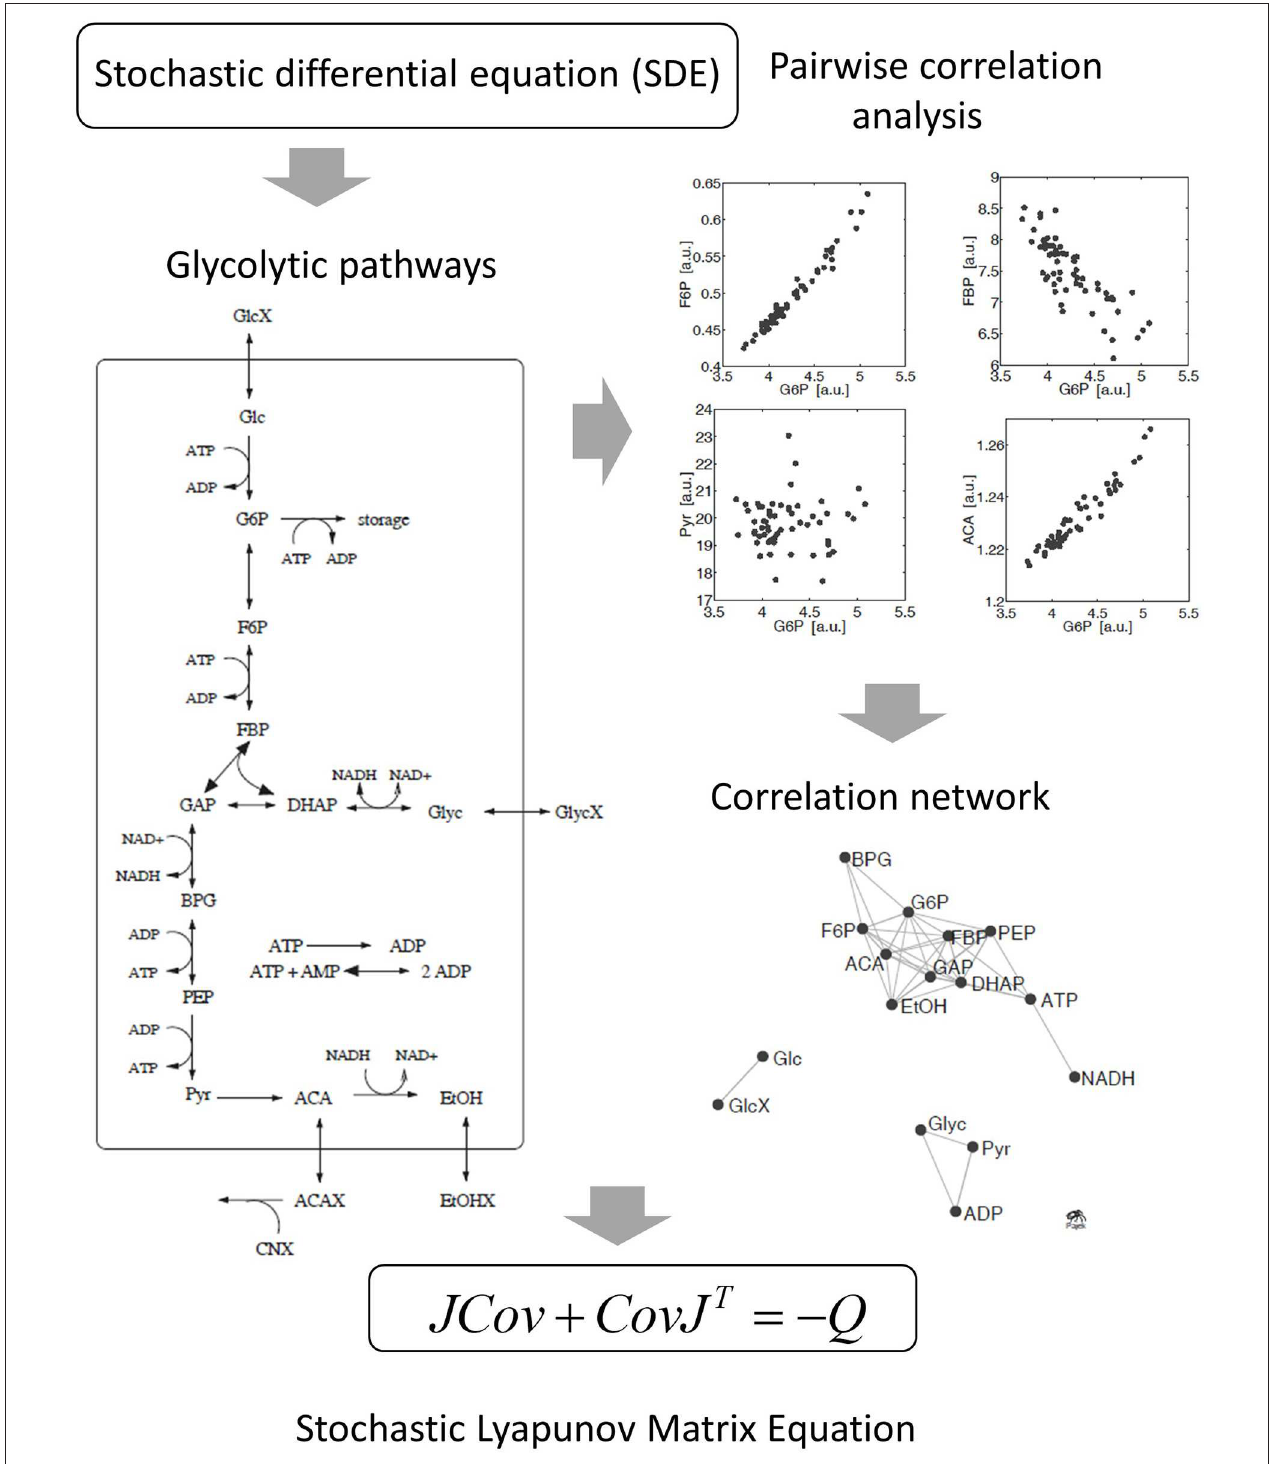
FIGURE 4 | Derivation of the stochastic Lyapunov Matrix Equation from fluctuating metabolic correlation networks [50]. Stochastic processes are introduced by adding Gaussian white noise to the ODE. Numerical solutions of independent replicates of the system demonstrate significant pairwise correlations between metabolites according to the experimental observations in real metabolomics data (see Figure 2 ). The concept is described by the stochastic Lyapunov matrix equation (for more details see text).